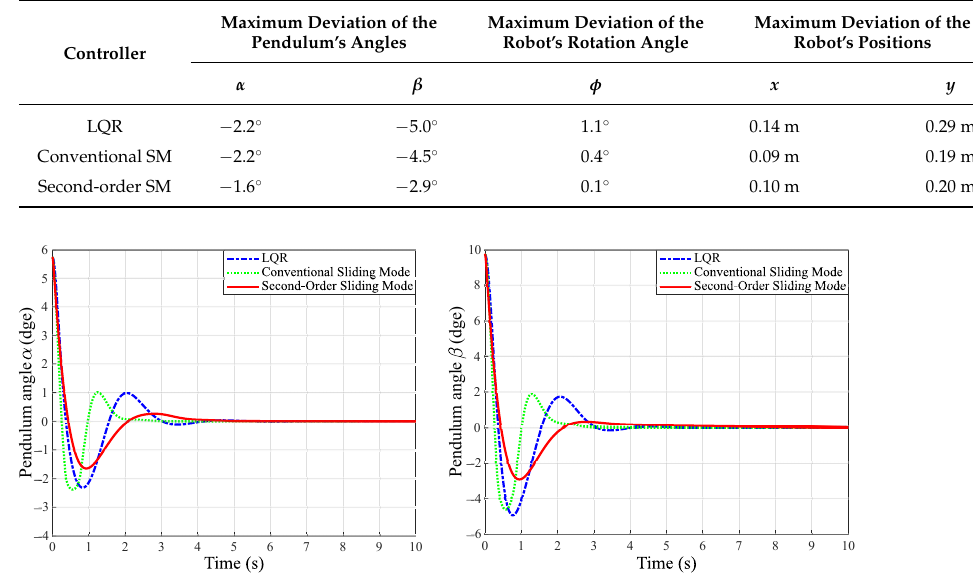
Figure 11. The simulation results compare the angle responses of the inverted pendulum on α and β , respectively.